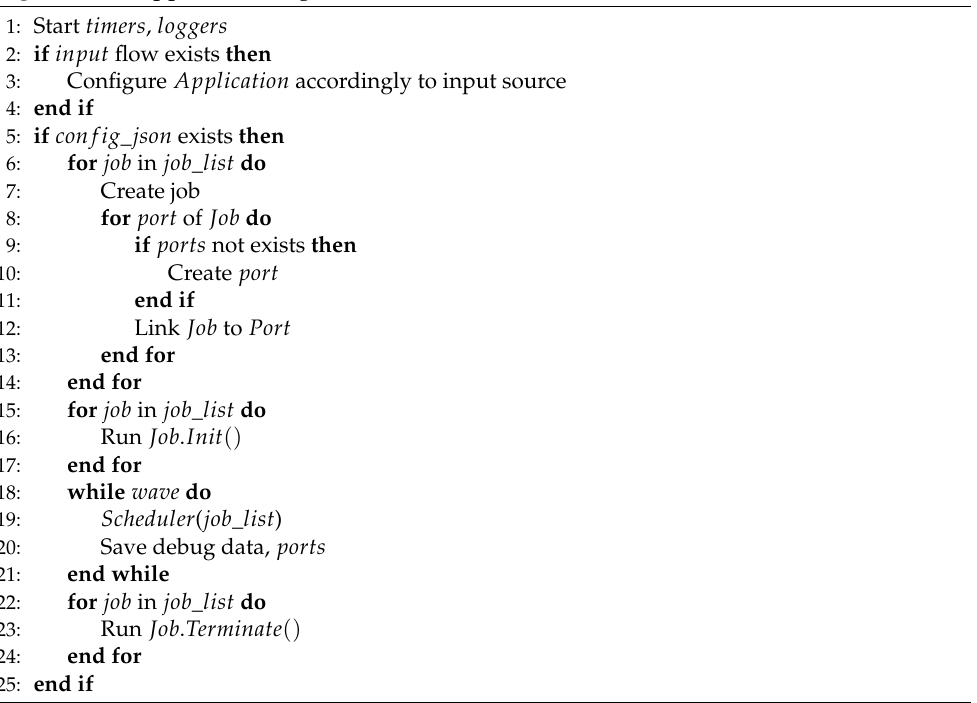
Algorithm 2 Application